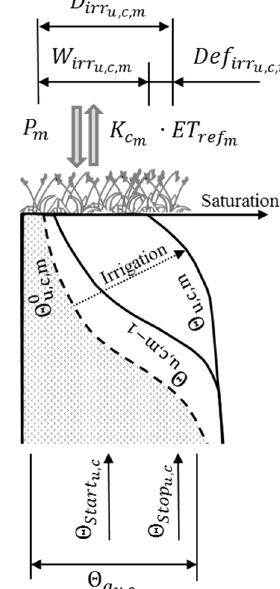
Figure 2. Outline showing how agricultural irrigation water demand is determined for a crop.